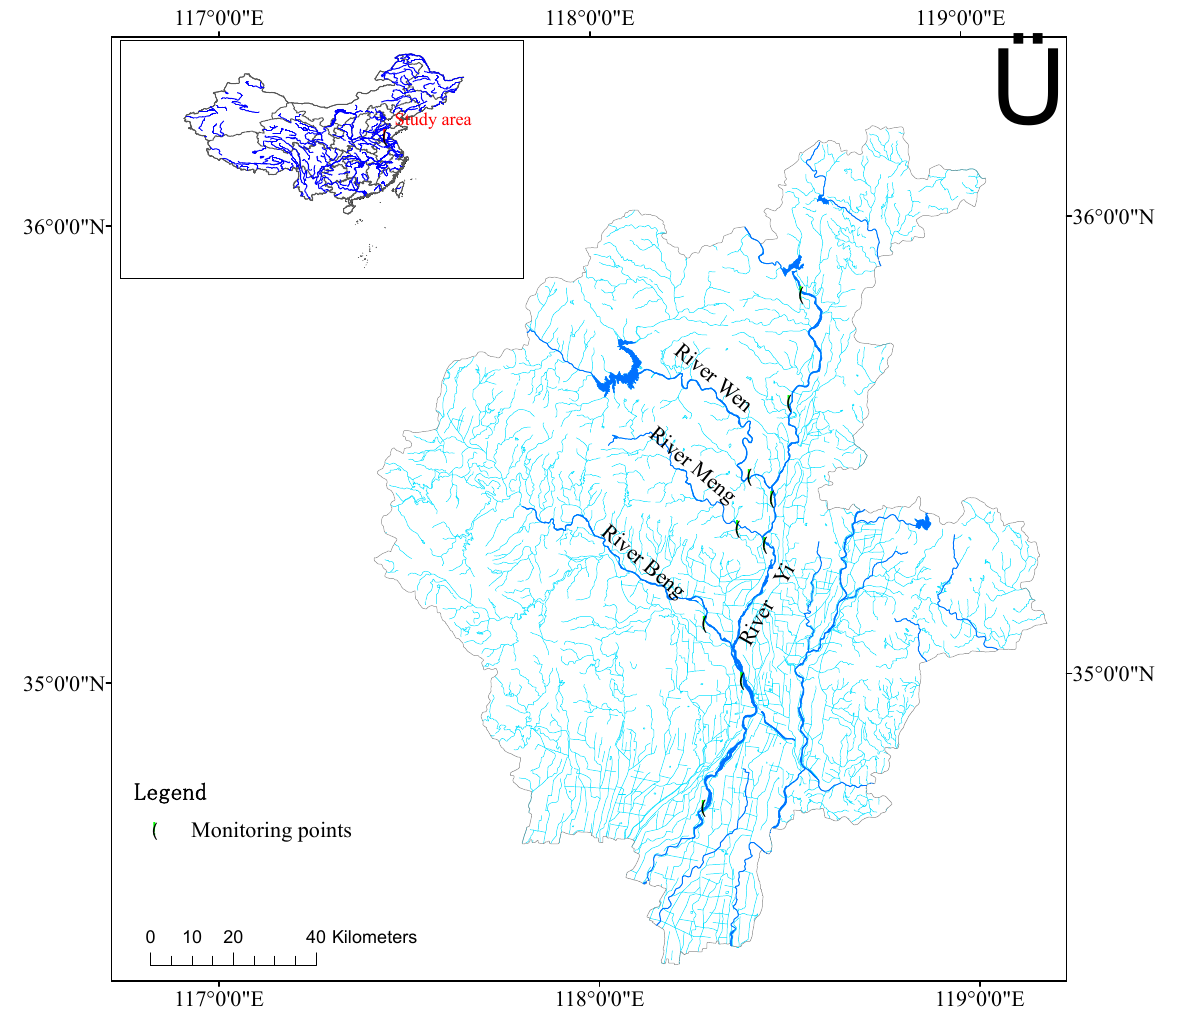
Figure 1. Study region and sampling locations. ArcMap version 10.8 (https://www.esri.com/ (accessed on 1 March 2021)) was used to create the map.